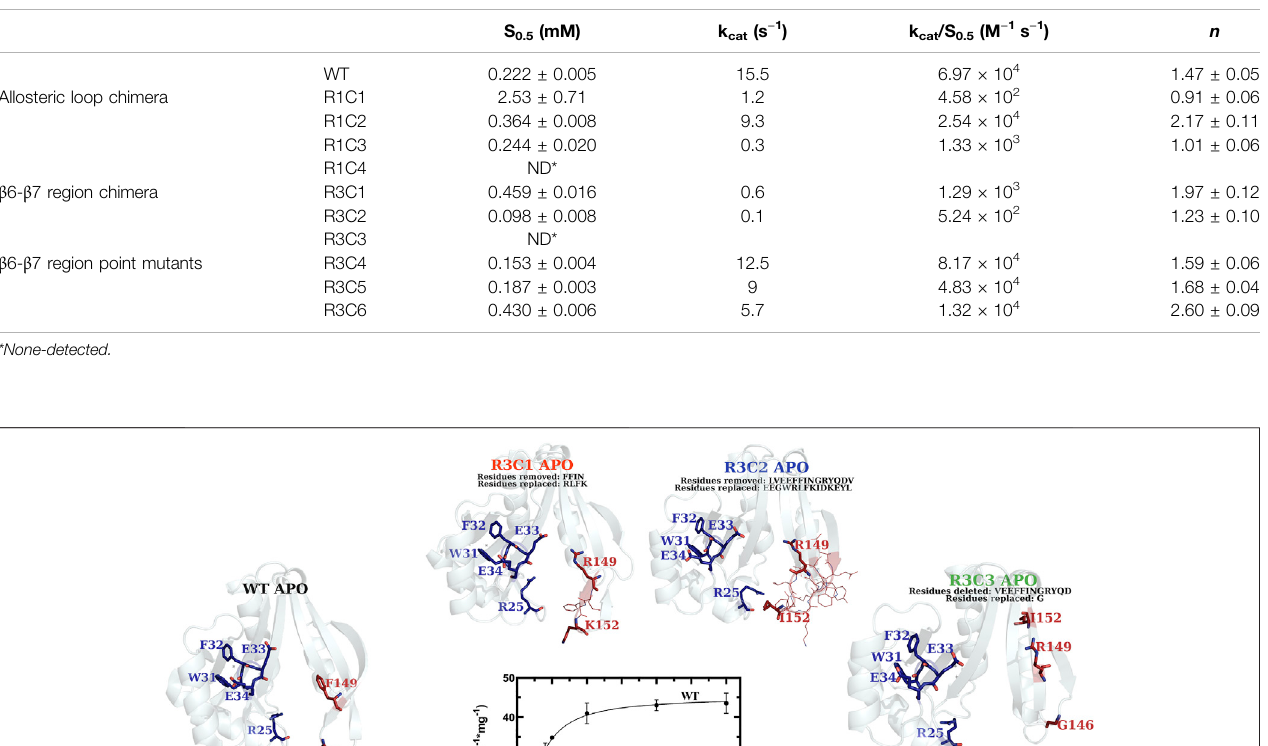
TABLE 1 | Kinetic parameters of WT VcSpeG and ten constructs.